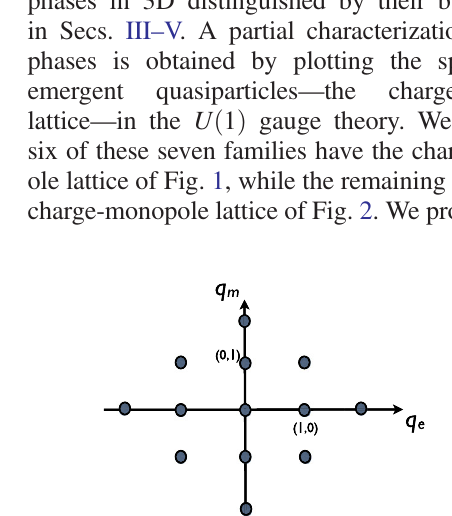
FIG. 1. Charge-monopole lattice at θ ¼ n π with n even.